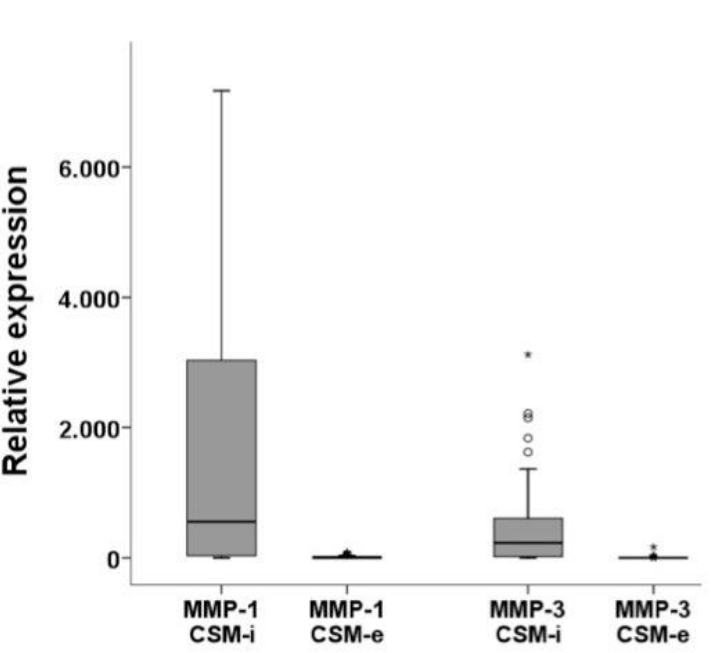
Figure 2. Relative expression levels of matrix metalloproteinases comparing CSM-i to CSM-e. Outliers are marked separately with *.